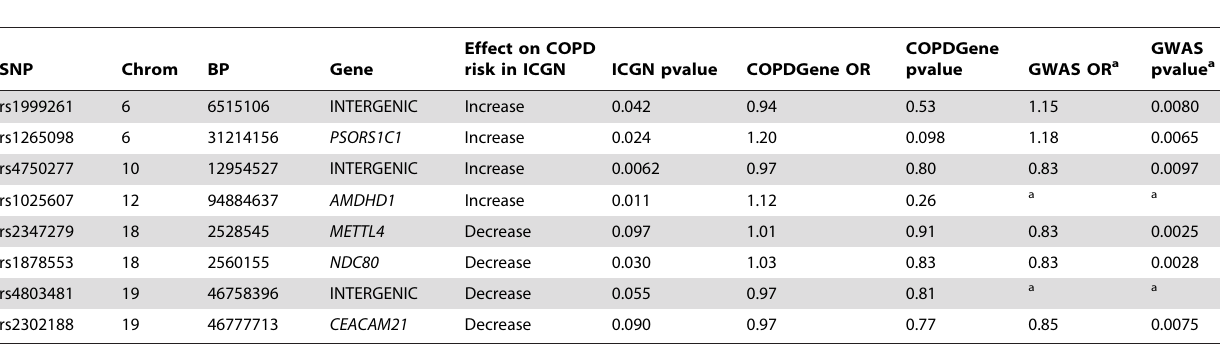
Table 3. Genetic association analysis of sputum expression quantitative trait locus (eQTL) single nucleotide polymorphisms (SNPs) with COPD